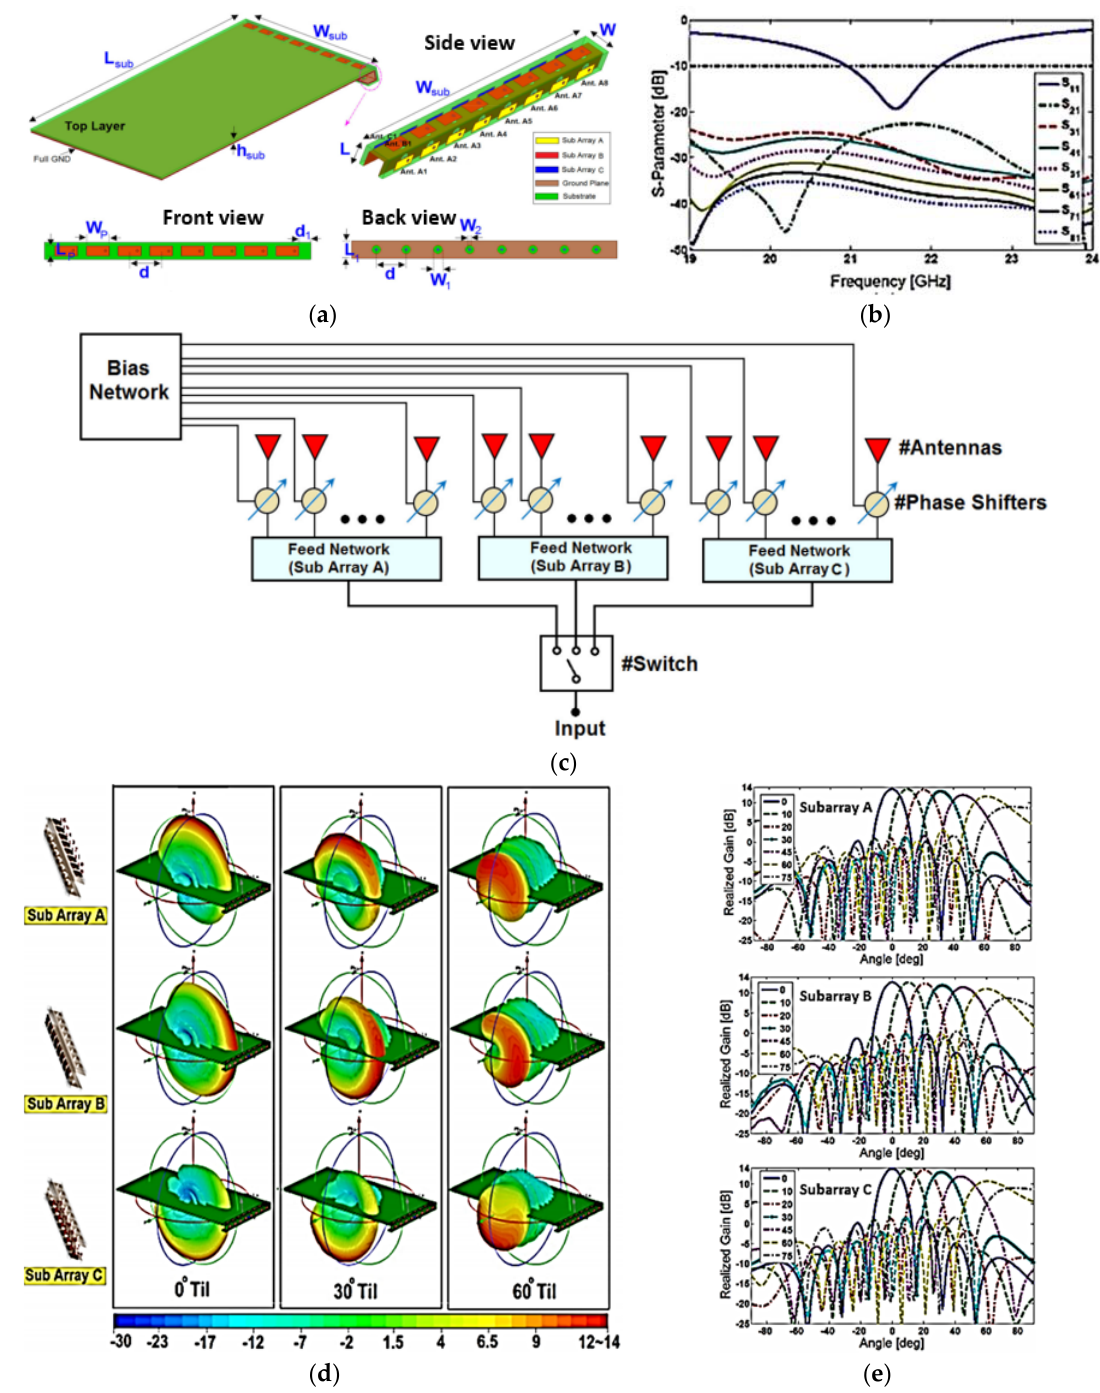
Figure 10. ( a ) Proposed view of 5G phased ‐ array antenna with full ground plane. ( b ) S ‐ parameters of proposed phased ‐ array antenna with eight elements. ( c ) Proposed phased ‐ array architecture. ( d ) 3D radiation patterns of each subarray at different scan angles. ( e ) 2D realized gain patterns at different scan angles. (Redrawn from [49])